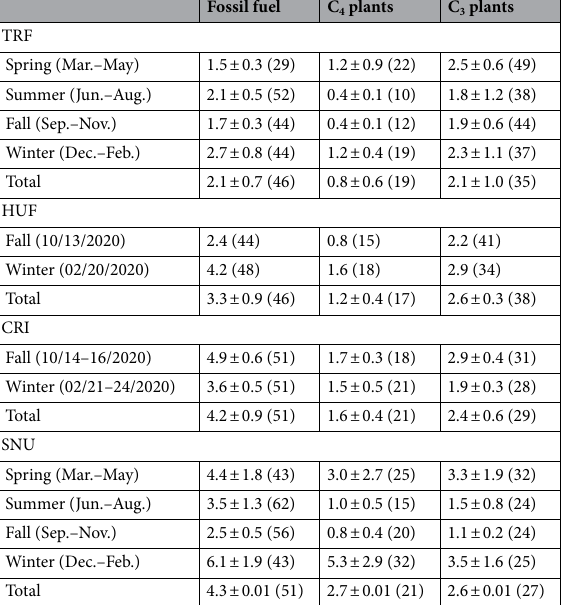
Table 2. The means and the standard deviations of the concentration (μg C m −3 ) of each source. The mean relative contribution (%) of each source to carbonaceous component of PM 2.5 is in